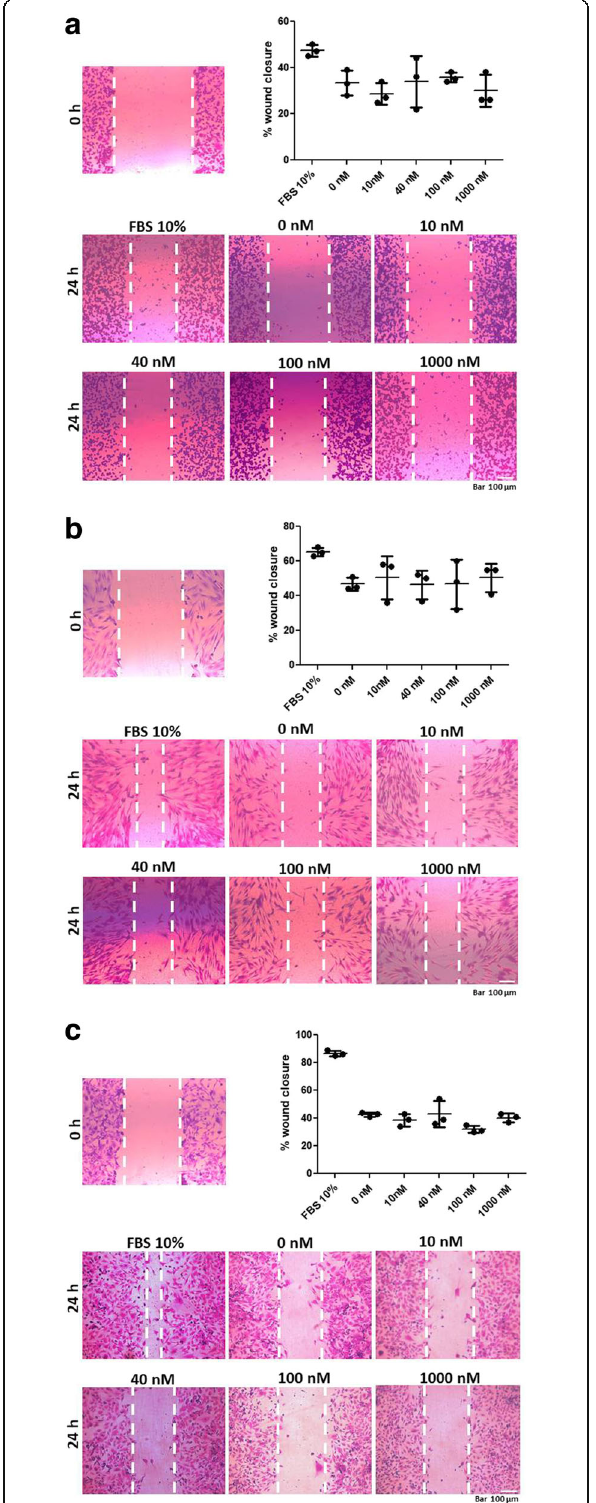
Fig. 3 ALT-C effects on: ( a ) MDA-MB-231 cells; ( b ) fibroblasts; and ( c ) HMEC-1 cells were plotted as a percentage of wound closure 24 h after wounding. FBS 10% represents cells in presence of medium with FBS (10%) as positive control. The assay was performed in triplicate with two independent assays ( n =2). p values were determined using ANOVA followed by Tukey ’ s test, considering significant when p <0.05. Representative photos of wounds were taken at time zero and 24 h after wounding. Cells were stained with crystal violet